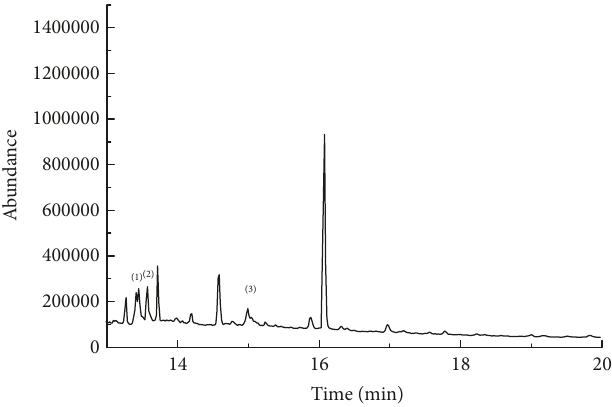
Figure 8: The chromatograms of the jasmine tea, (1) bifenthrin, (2) fenpropathrin, and (3) permethrin.